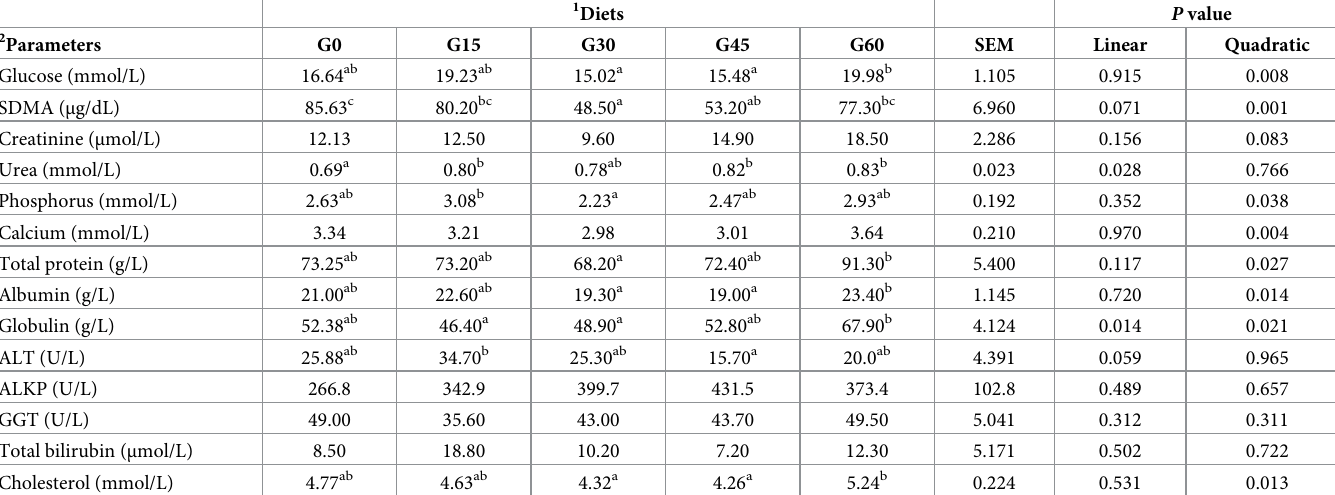
Table 5. Effect of red grape pomace-containing diets on hematological parameters of 16-week-old Hy-Line Silver Brown